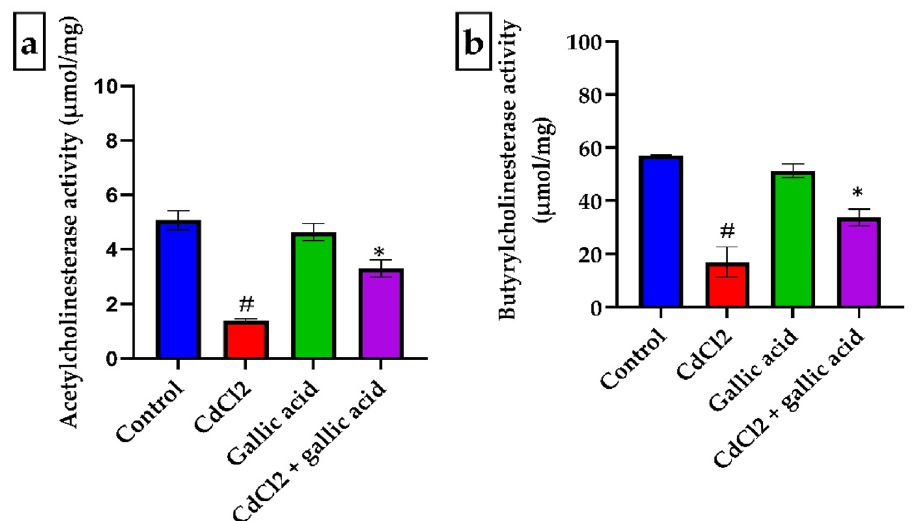
Figure 2. Gallic acid reverses the inhibition of ( a ) acetylcholinesterase (AChE) and ( b ) butyrylcholinesterase (BChE) of rats administered with distilled water, CdCl 2 alone, gallic acid alone, and CdCl 2 + gallic acid (20 mg/ kg). The data is represented as mean ± SD (n = 5). # Significant at p < 0.05 compared to the control; *Significant at p < 0.05 compared to the CdCl 2 only